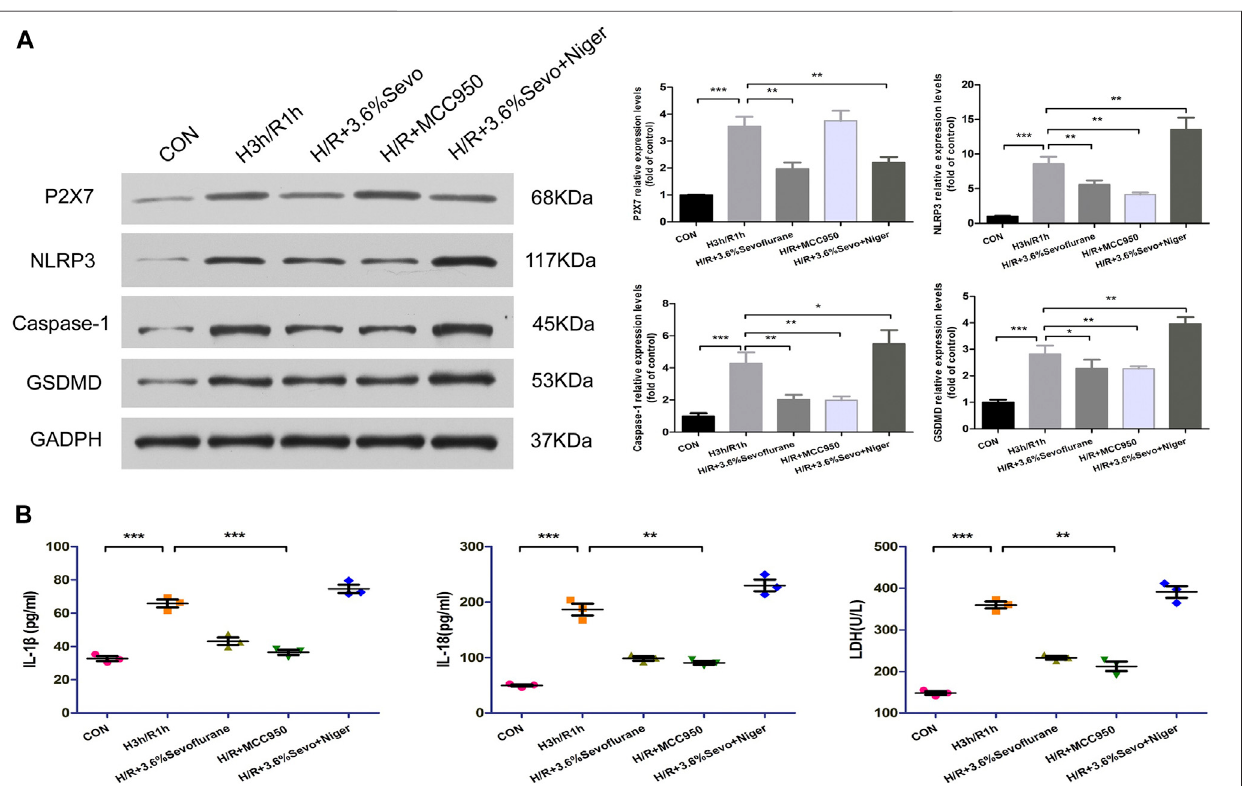
FIGURE7| EffectsofNLRP3inhibitorand agonistonNRVMafterSevo fl uranepretreatment (A) EffectsofNLRP3inhibitor andagonistontheprotein expressionof P2X7,NLRP3,Caspase-1andGSDMDinNRVMafterSevo fl uranepretreatmentbyimmunoblotting.Dataareexpressedrelativetothemeanvalueforcontrolgroupand were presented as mean ± SD (n (cid:1) 3). * p < 0.05, ** p < 0.01, *** p < 0.001 vs respective controls (B) Effects of NLRP3 agonists and inhibitors on the levels of IL-1 β , IL-18 and LDH after H/R of cardiomyocytes. All values are expressed as mean ± SD (n (cid:1) 3). * p < 0.05, ** p < 0.01, *** p < 0.001 vs respective